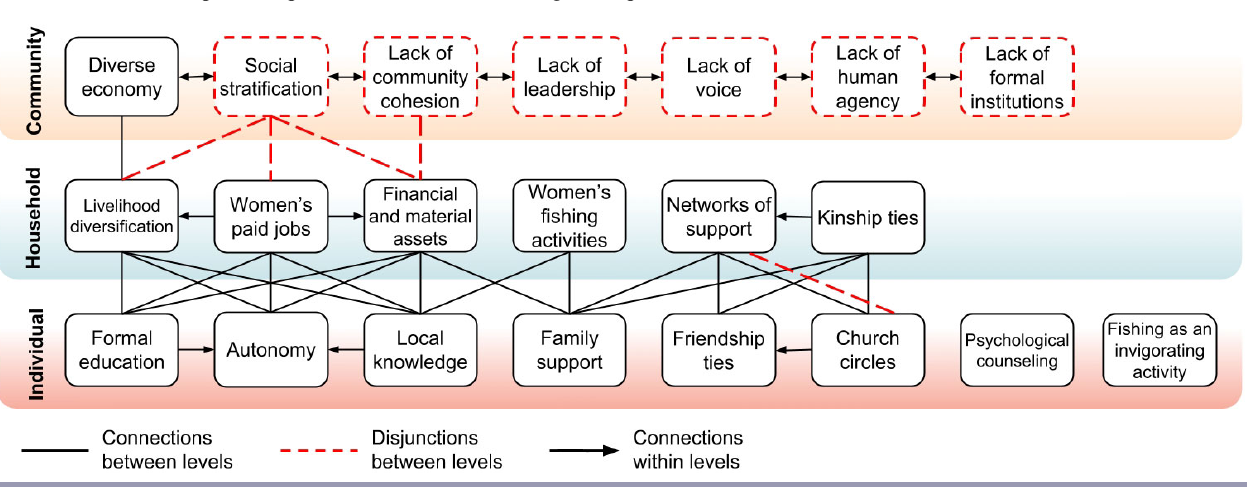
Fig. 2 . Main resilience features among the three levels (individual, household, and community), and the connections and disjunctions among them. The red dashed boxes represent features that decreased community resilience. The black boxes represent features that contributed to the resilience of at least one level. The red dashed lines represent disjunctions, or “negative” connections, while the black lines represent “positive” connections among level-specific resilience